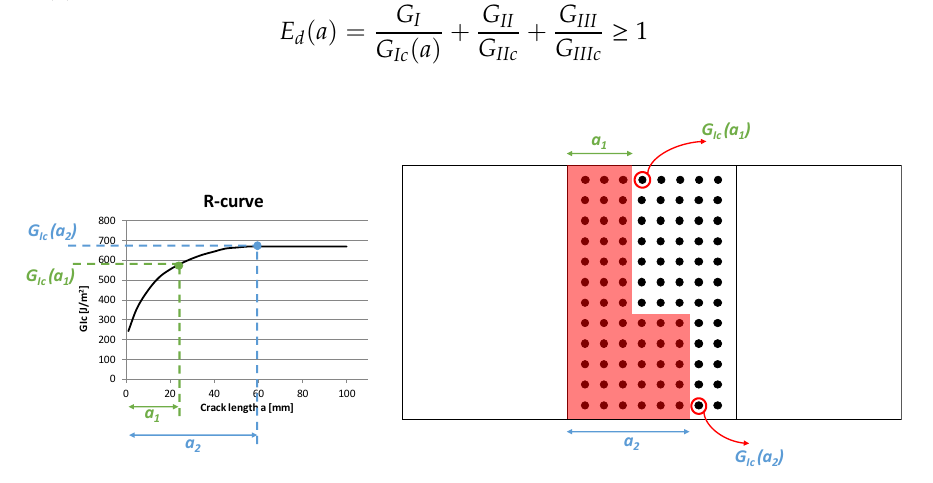
Figure 8. Fiber bridging modulus.